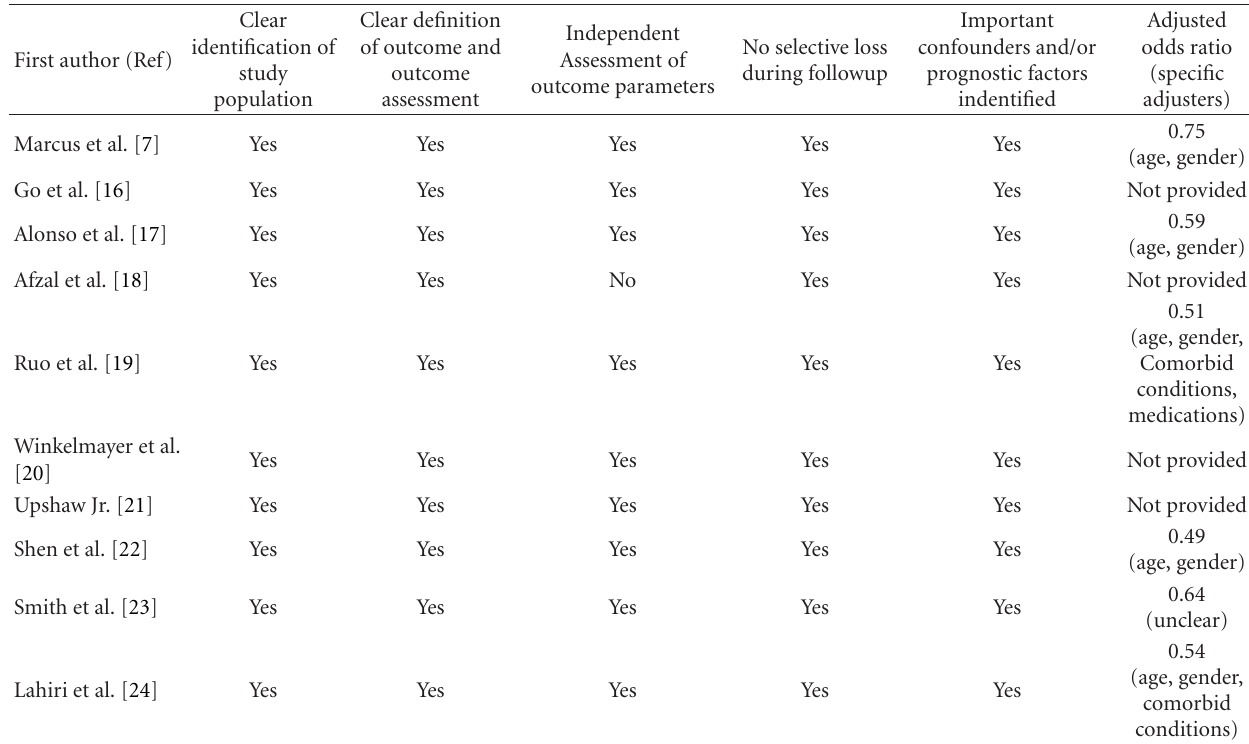
Table 2: Study quality summary.